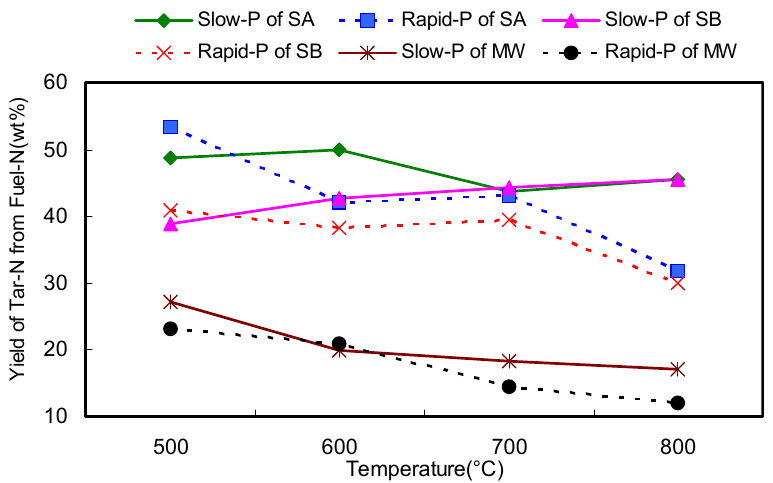
Figure 5. Tar-N yield during a series of pyrolysis